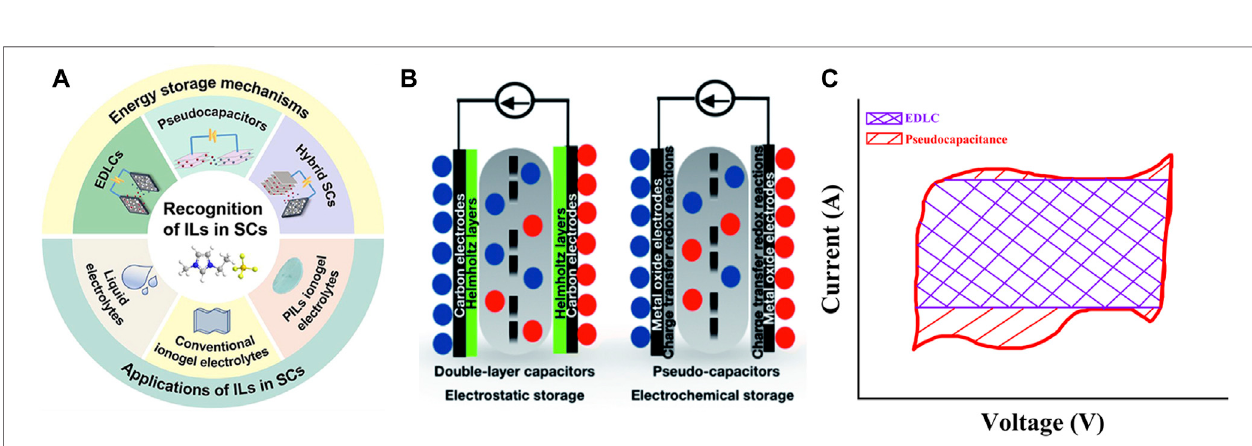
FIGURE 2 | (A) ILs application in SCs. Reprinted with permission from (Pan et al., 2020), Frontiers in chemistry, (B) Charge storage mechanism in electric double layer capacitor (EDLC) and pseudocapacitor Reprinted from (Panda et al., 2020), Royal Society of Chemistry. (C) CV of electric double layer capacitor (EDLC) and pseudocapacitor. Reprinted with the permission from (Lin Z. et al., 2011) American Chemical Society.